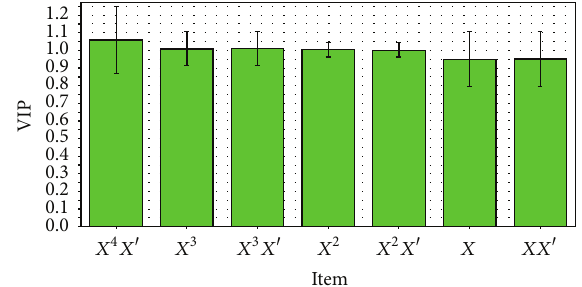
Figure 2: Variable importance of each item.